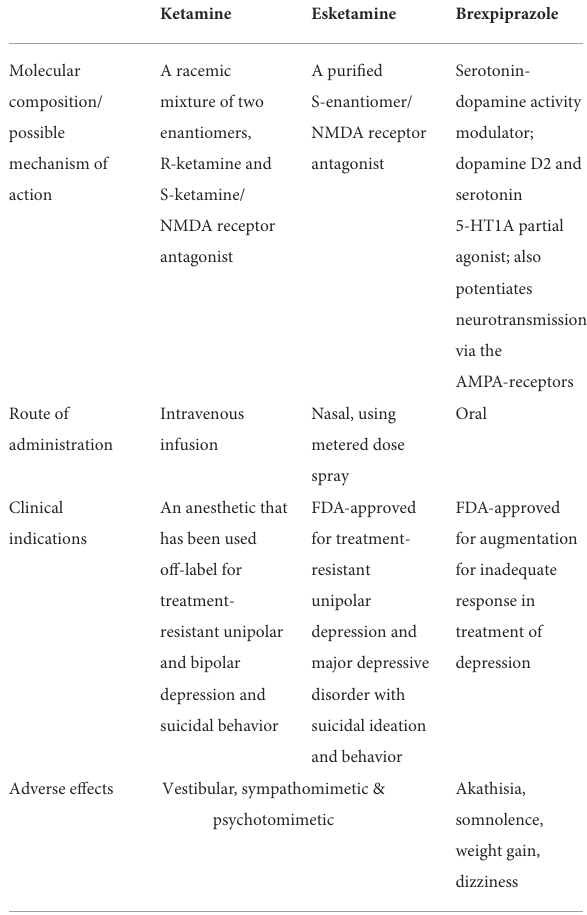
TABLE 1 The profile of ketamine/esketamine and brexpiprazole. Esketamine